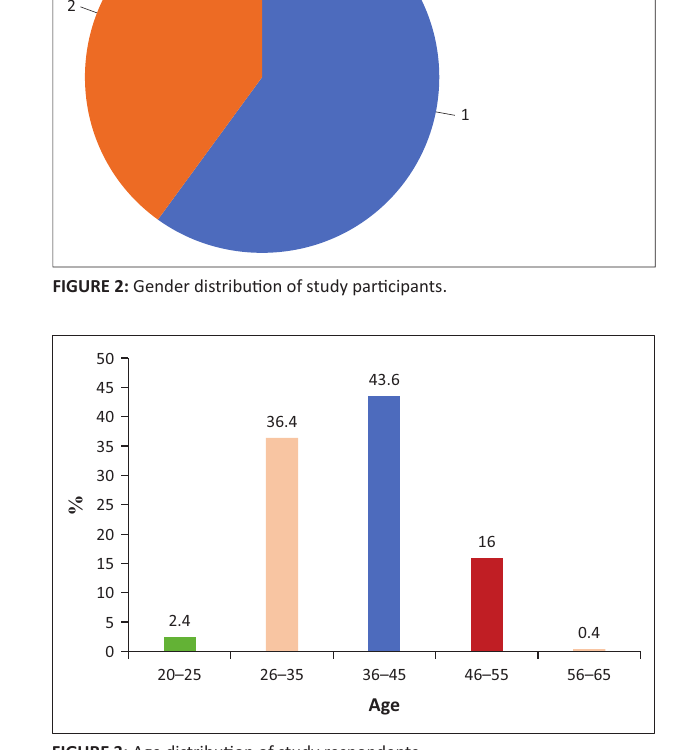
FIGURE 3: Age distribution of study